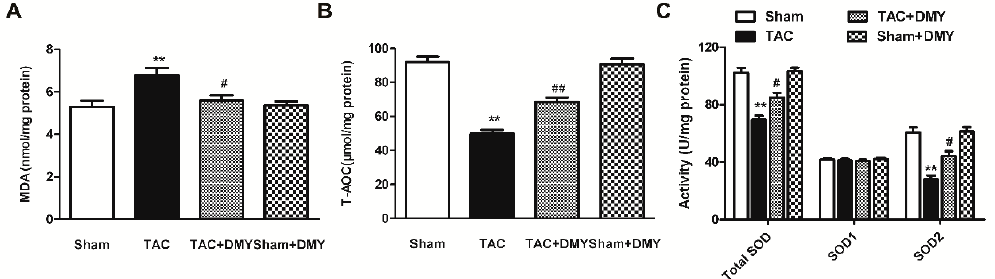
Figure 7 . Effect of DMY on myocardial malondialdehyde (MDA) levels, total antioxidant capacity (T-AOC), and superoxide dismutase (SOD) activity in mice after TAC. ( A ) Myocardial MDA levels were detected. ( B ) Total myocardial antioxidant capacity (T-OAC) was measured. ( C ) SOD activity in the myocardium was measured. ** p < 0.01 versus Sham; # p < 0.05, ## p < 0.01 versus TAC ( n = 8). 2.7. DMY Increased SIRT3 Expression and Activity in the Myocardium of Mice after TAC